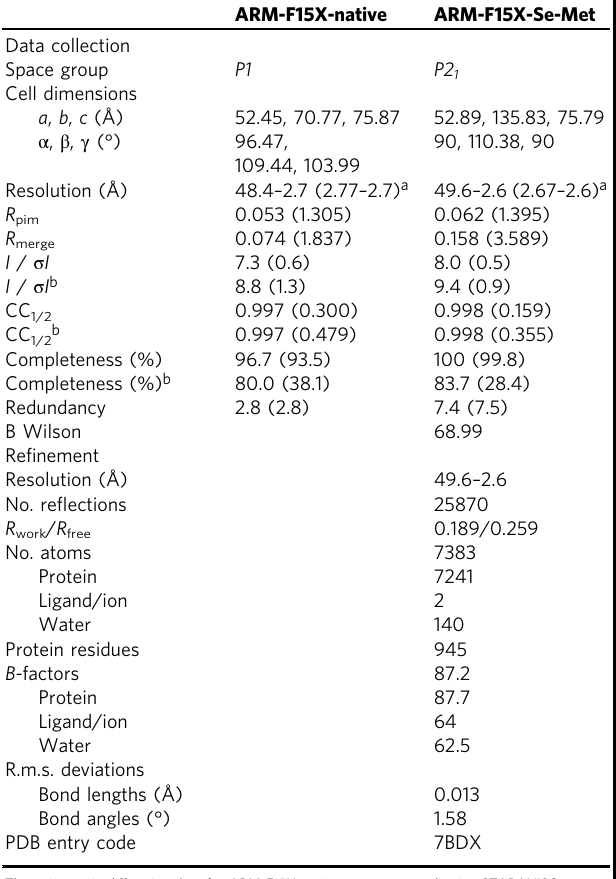
The anisotropic diffraction data for ARM-F15X-native were truncated using STARANISO to includeall valid data (re fl ections with I/ σ (I) of 1.2) to resolutions of: 2.68, 3.22 and 2.50Å along the 0.705 a * − 0.402 b * − 0.584 c *, 0.180 a * + 0.970 b * − 0.164 c *, 0.196 a * − 0.262 b * + 0.945 c * directions, respectively. Similarly, the anisotropic diffraction data for ARM-F15X-SeMet were truncated using STARANISO to include all valid data to resolutions of: 2.69, 2.91, and 2.47Å along the 0.861 a * − 0.508 c *, b *, 0.052 a * + 0.999 c * directions, respectively. a Values in parentheses are for highest-resolution shell. b Values after truncation by